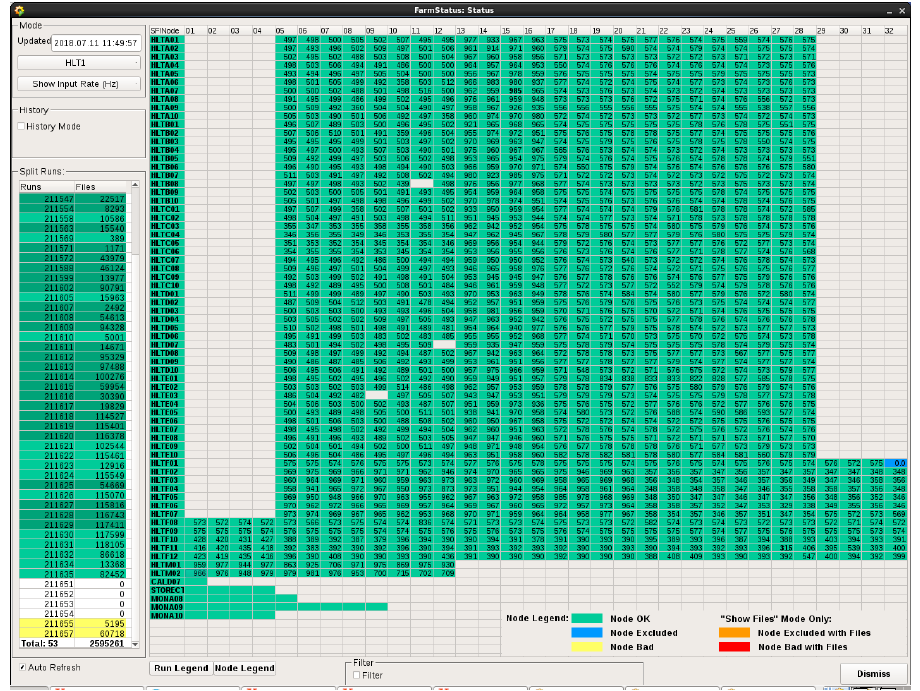
Figure 6. LHCb HLT instantaneous input rate (Hz) node by